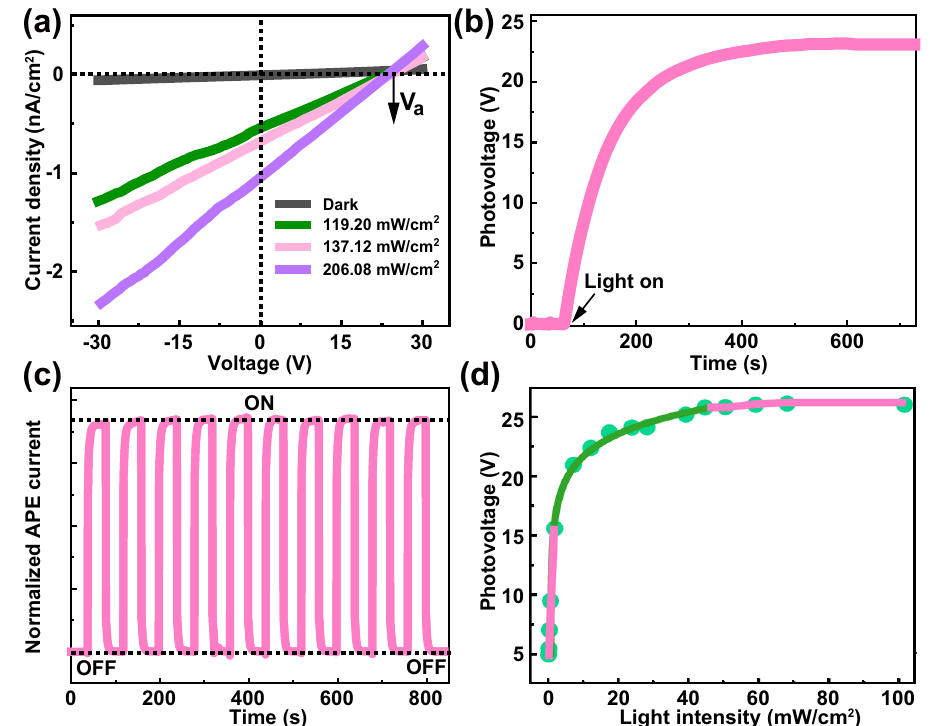
Fig.4|Anomalousphotovoltaiceffect(APE)behaviorsofABI.a Current-voltage ( I – V) tracesunderdifferentlightintensities( I t >89mW/cm 2 ). b Open-circuitvoltage ( V a ) versus time when the light is turned on. c The real time-dependent